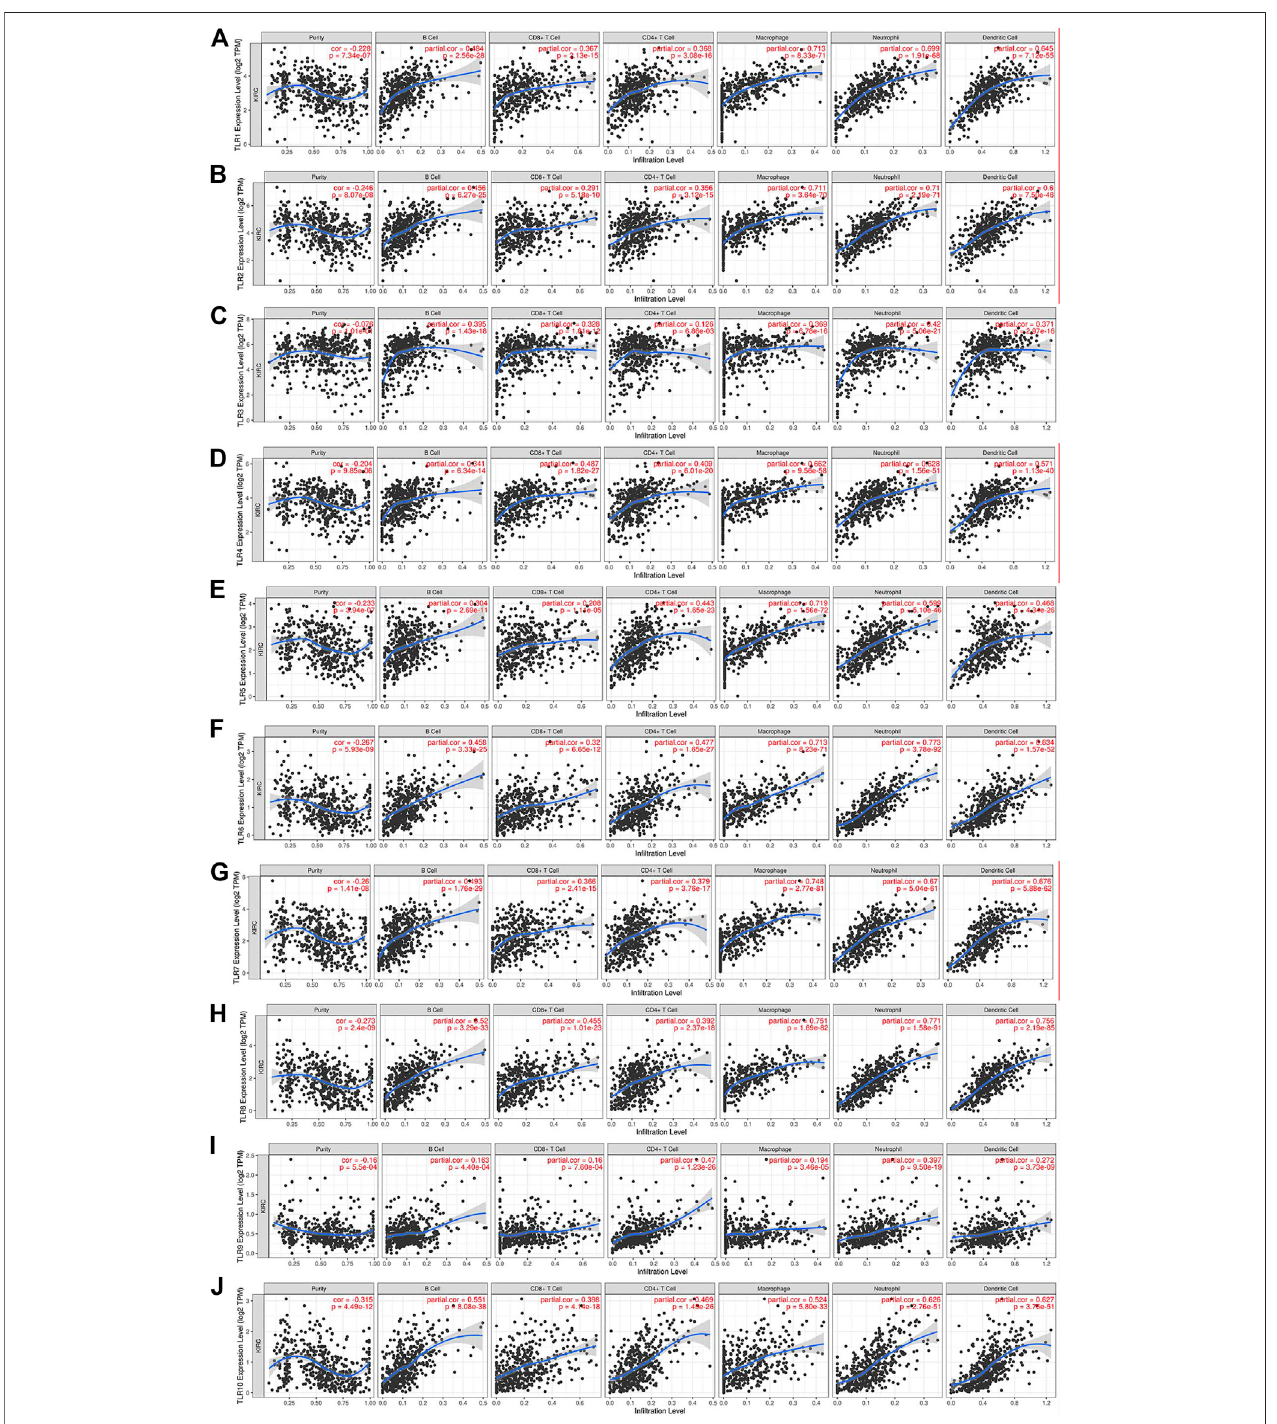
FIGURE9| TherelationshipsbetweentheexpressionlevelsofTLRsandimmunecellsin fi ltrationinKIRC.Theassociationsofimmunecellsin fi ltrationlevelswiththe expression levels of TLR1 (A) , TLR2 (B) , TLR3 (C) , TLR4 (D) , TLR5 (E) , TLR6 (F) , TLR7 (G) , TLR8 (H) , TLR9 (I) and TLR10 (J) in KIRC.